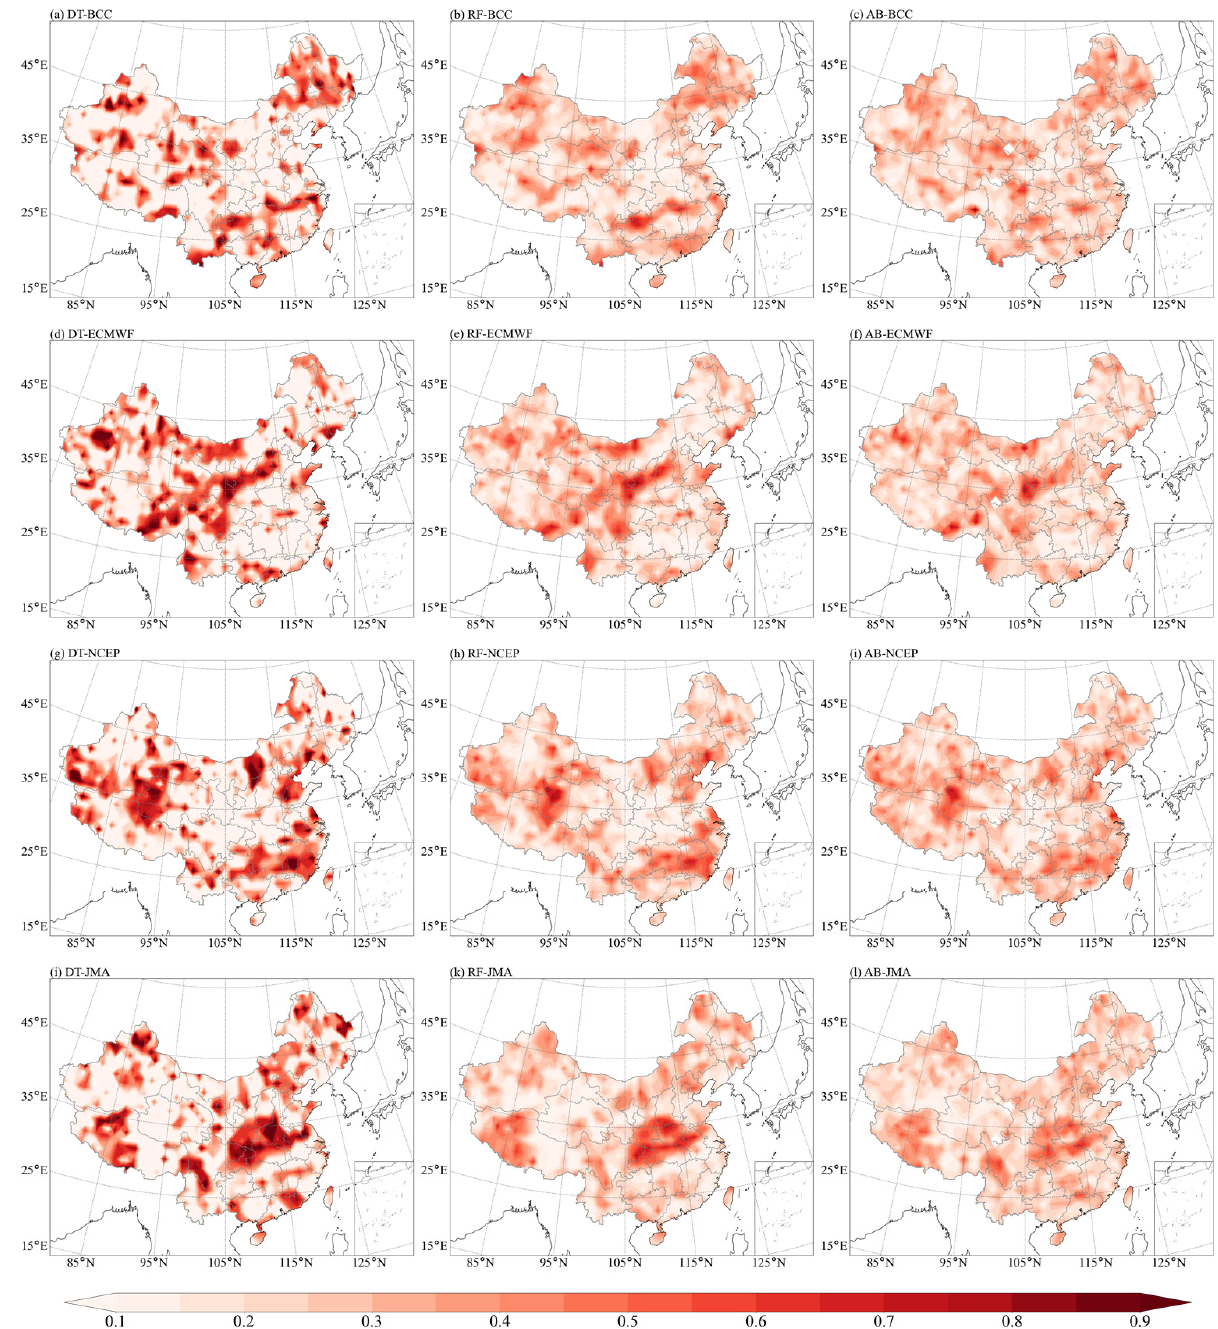
Figure 8. The importance of four models in the algorithms for decision trees, random forests, and AdaBoost: ( a ) BCC’s importance in DT algorithm, ( b ) BCC’s importance in RF algorithm, ( c ) BCC’s